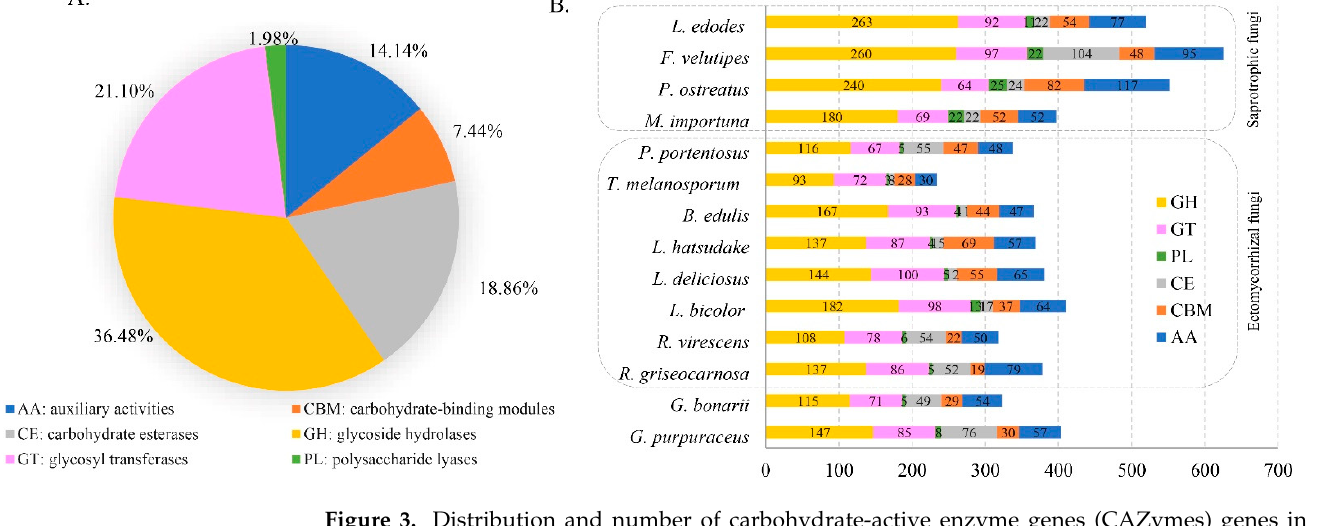
Figure 3. Distribution and number of carbohydrate-active enzyme genes (CAZymes) genes in G. purpuraceus and other 13 fungi. ( A ) Distribution of CAZymes in G. purpuraceus . ( B ) Comparison of CAZymes in the 14 fungi.